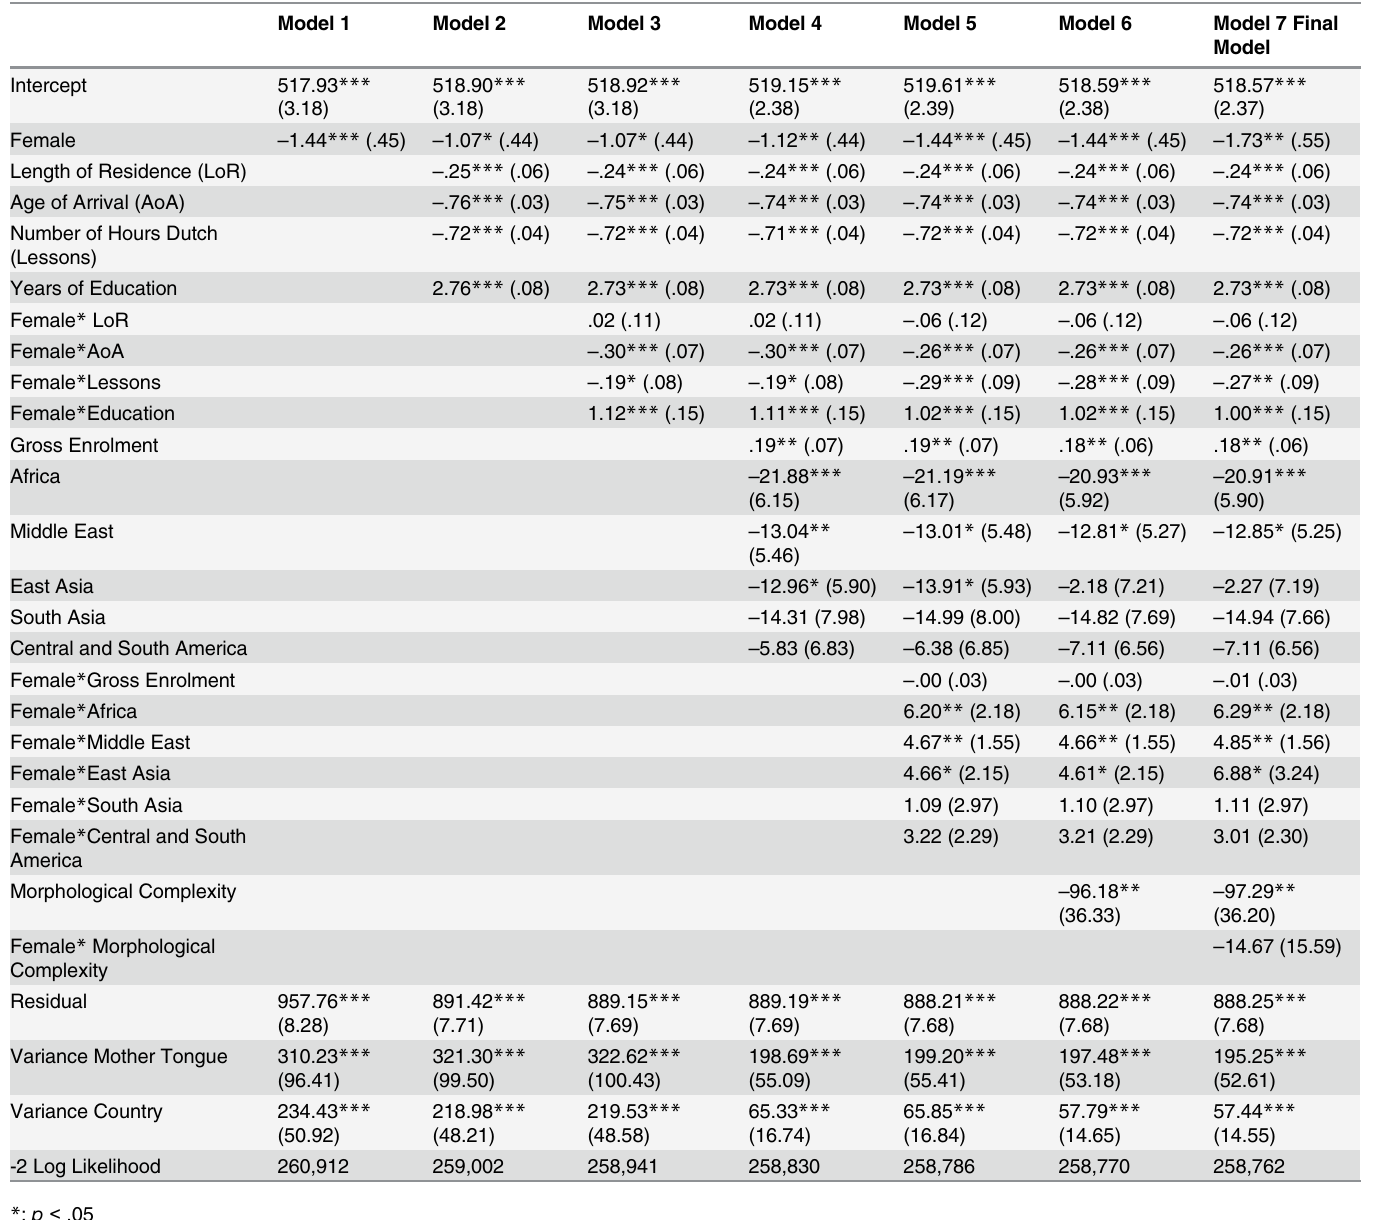
Table 4. Cross-classified Multilevel Model Parameter Estimations for Measures of the Dutch Reading Proficiency Test (Standard Errors in Paren- theses) per Mother Tongue and Country of